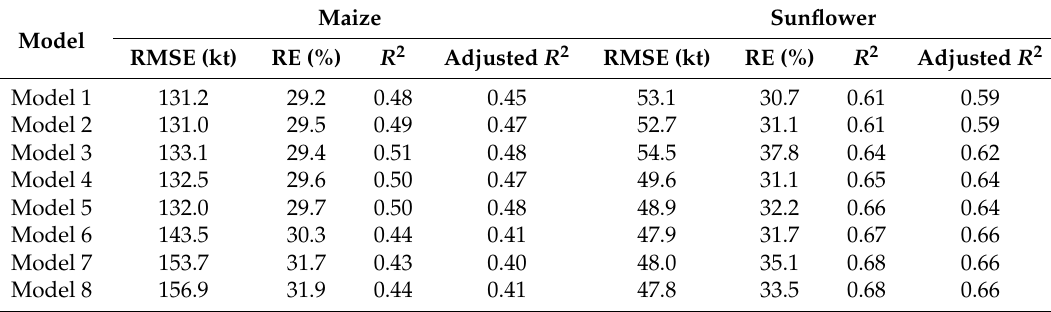
Table 4. The accuracies of maize and sunflower production estimations. Maize Model